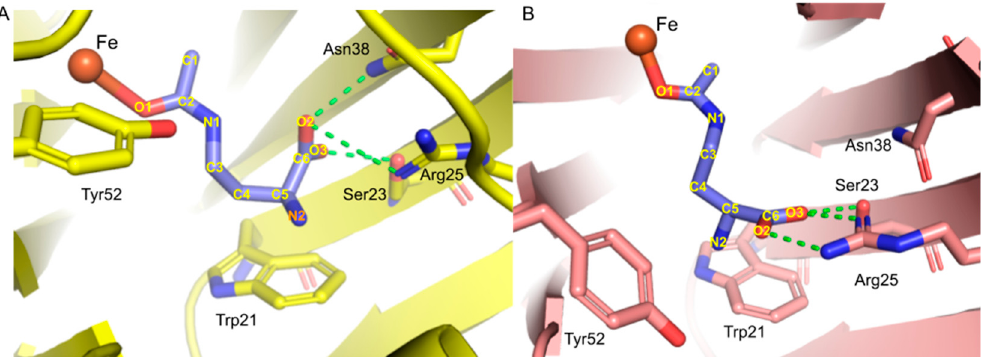
Figure 4. The centroid geometries for dominating clusters from 100-ns-long MD for the model with four-coordinate Fe 2+ and Trp21-A: ( A ) centroid of an active site in monomer 1; ( B ) centroid of an active site in monomer 2. Hydrogen bonds are shown as green dashed lines.